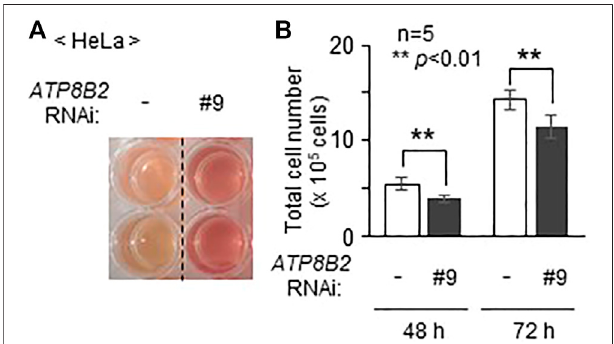
FIGURE 5 | Suppression of cell growth upon lowering the expression of ATP8B2 . (A) Mock transfected HeLa cells (-) or HeLa cells transfected with siRNA against ATP8B2 (#9) were cultured for 72 h. Acidi fi cation of the culture medium was monitored by visual-checking the color of the medium. (B) Total number ofcells cultured as in (A) wascounted at the indicated time after transfectionwiththerespectivesiRNA( n =5).Dataindicatemeans±SD.** p < 0.01, by Student ’ s t